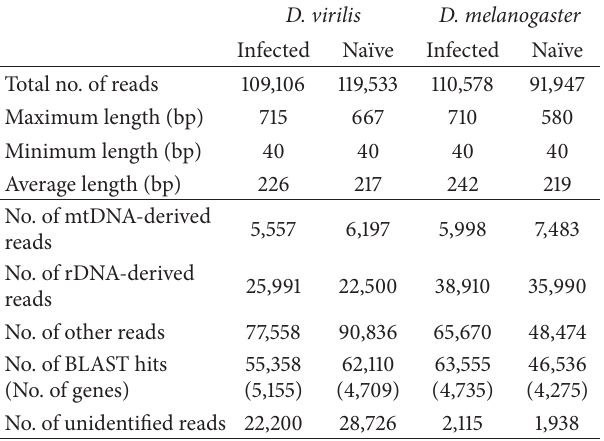
Table 1: Summary of statistics of 454GS Junior sequencing and BLAST